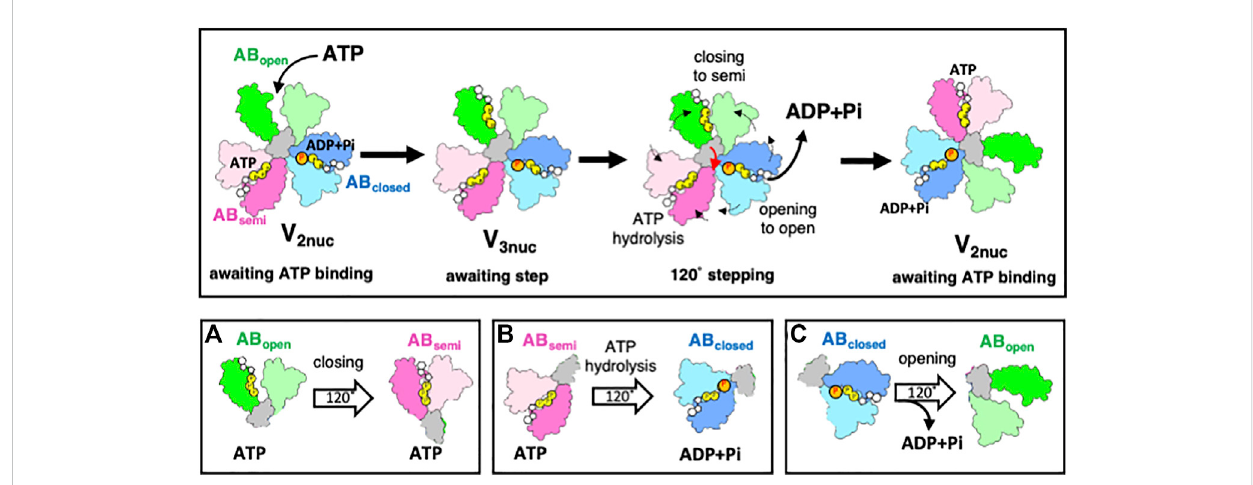
The rotary mechanism of the V 1 domain powered by ATP hydrolysis. The fi gure shows schematic models of AB open , AB semi , and AB closed in green, pink, and blue respectively. The grey region shows the coiled region of the D subunit in contact with A 3 B 3 . In the V 2nuc state, waiting for ATP binding, bindingofATPontoAB open doesnotresultina120 ° step.IntheV 3nuc state,boththeclosingofAB open andATPhydrolysisinAB semi resultintheopeningof AB closed , accompanied by ADP and Pi release. The catalytic events in three AB dimers occur simultaneously with a 120 ° step of DF, leading to a structural transition from V 3nuc to V 2nuc . The lower part of the fi gure illustrates the simultaneous occurrence of catalytic events at the three catalytic dimers